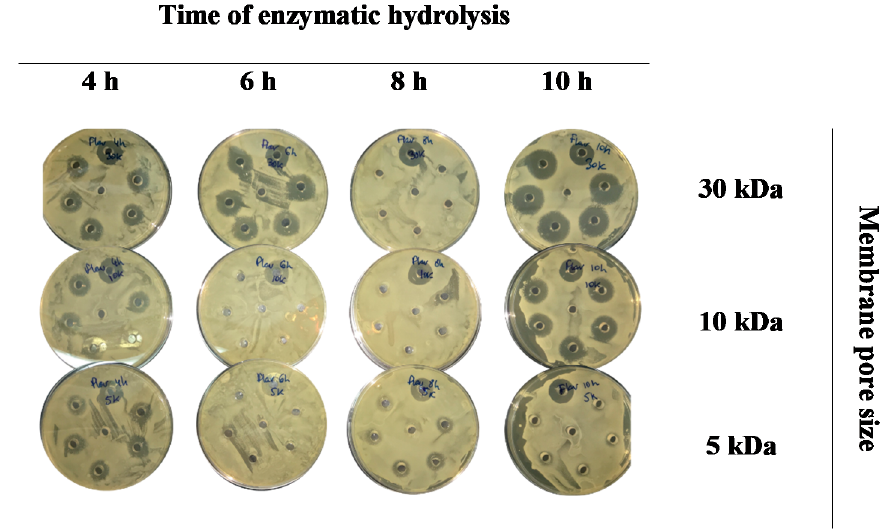
Figure 3. Antimicrobial activity of porcine liver hydrolysates generated by Flavourzyme at different hydrolysis times (4, 6, 8, and 10 h) and filtration through three pore sizes (5 kDa, 10 kDa, and 30 kDa) against Brochothrix thermosphacta .